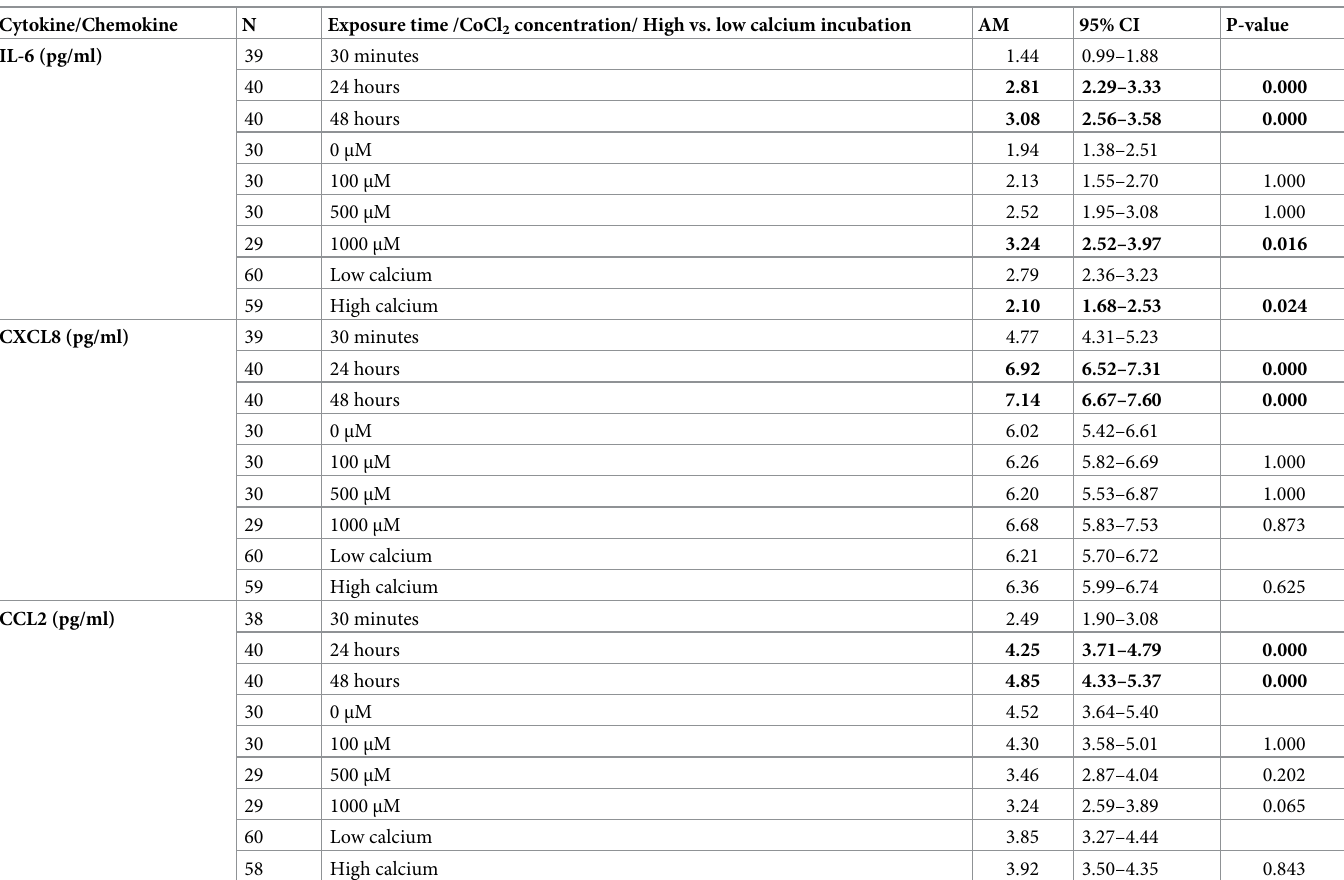
Table 1. ANOVA analyses for dose- and time-trends for IL-6, CXCL8 and CCL2 secretion from HaCaT cells. Cytokine/Chemokine